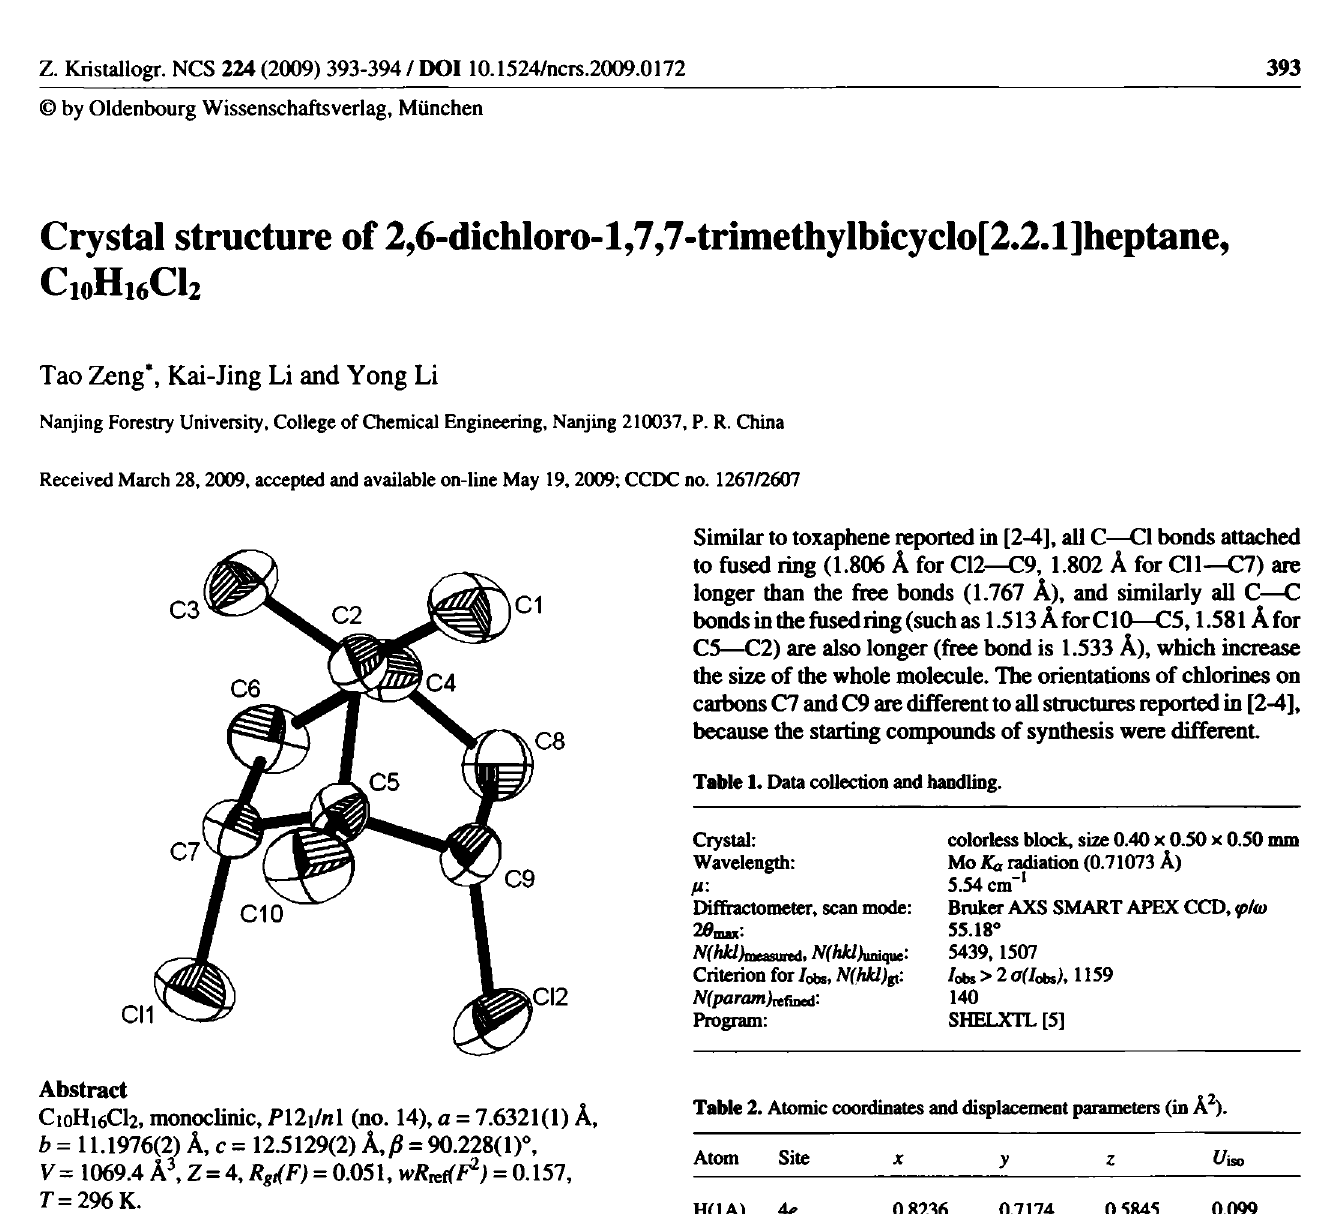
Table 2. Atomic coordinates and displacement parameters (in Â 2